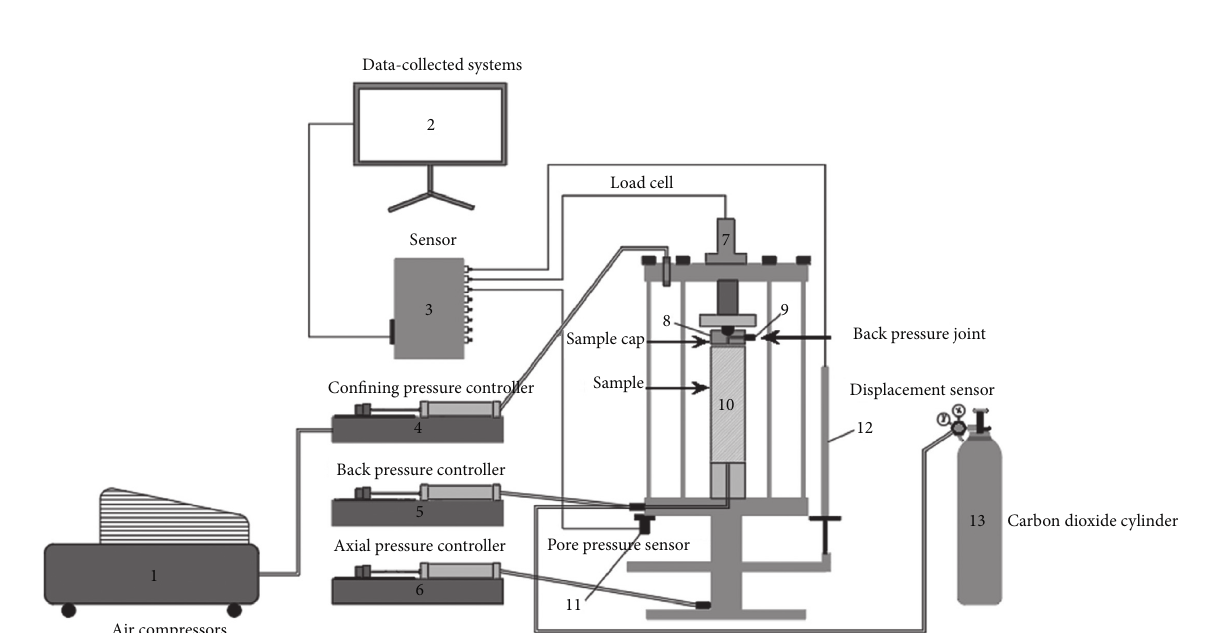
Figure 3: Standard stress path of the triaxial test system.